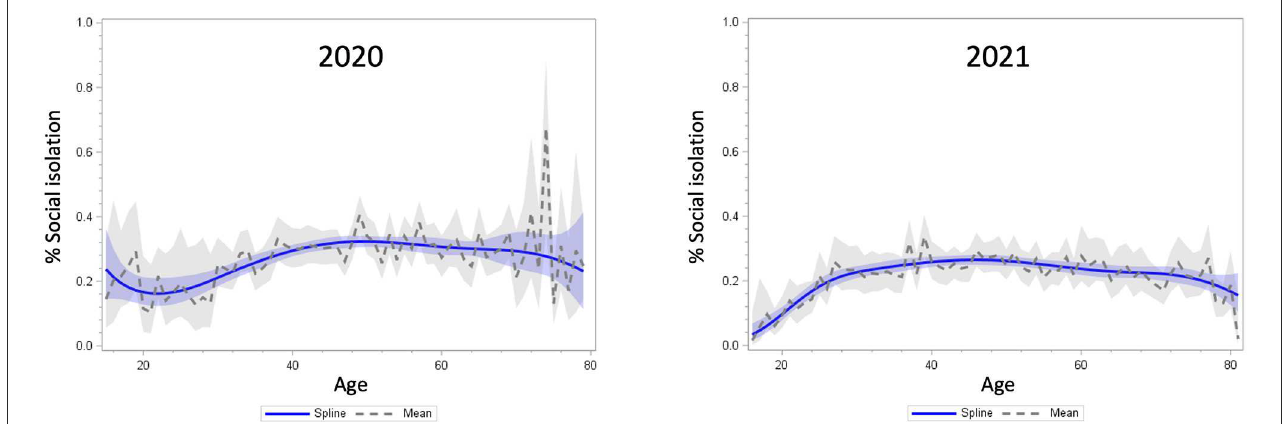
FIGURE1 Distribution of the proportion of social isolation by age in 2020 (left) and 2021 (right) . The confidence bands reflects the 95% confidence intervals of the lines.